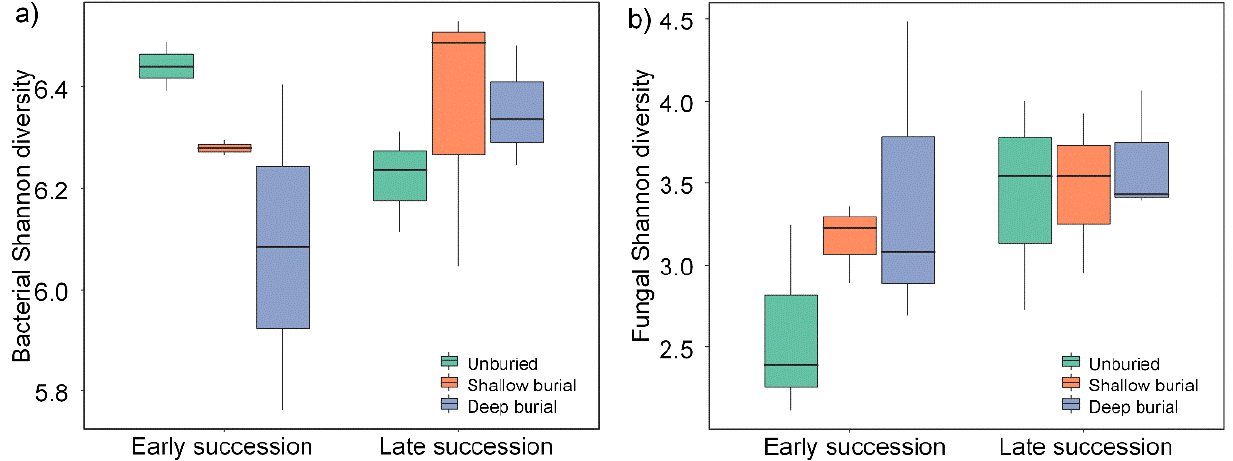
Figure 2. Shannon diversity of bacterial communities ( a ) and fungal communities ( b ) in the three soil depths under early and late succession. There are no significant effects of succession periods or sample depths on bacterial or fungal Shannon diversity.